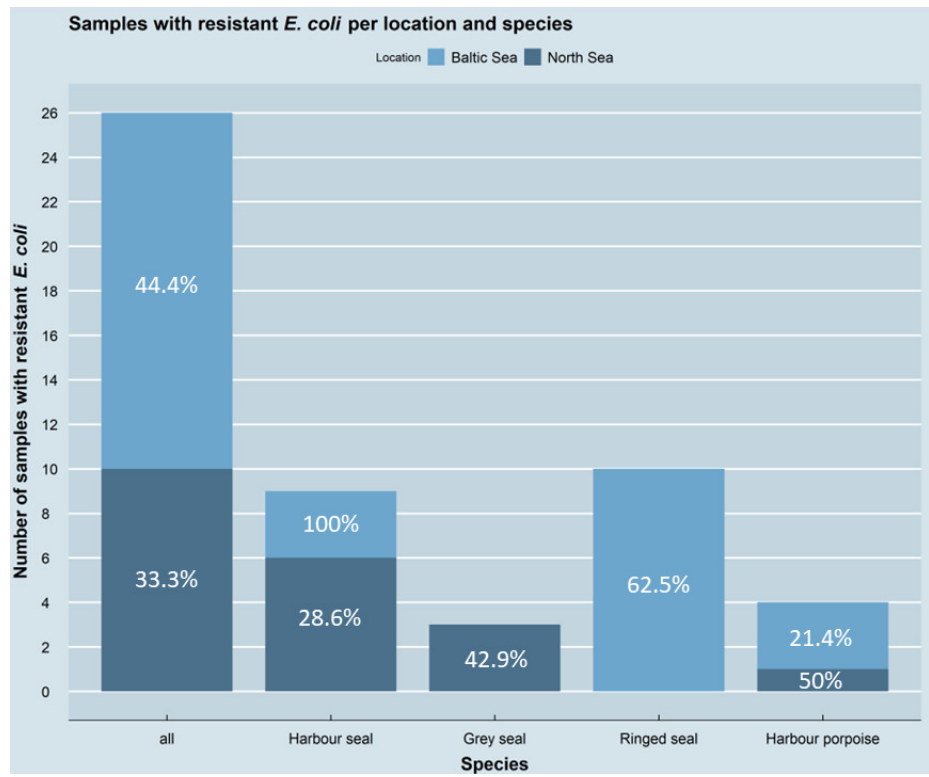
Figure 2. Number and percentage of resistant E. coli per location and species. Shown are all samples ( n = 26) with at least one resistant E. coli isolate as well as their distribution over the two sampling locations and the four species. Percentages indicate proportion of samples with resistant E. coli isolates to the total number of samples for both locations as well as for all tested species. The figure was created using RStudio version 1.4.1103 (R version 4.1.2) with the package ggplot2.